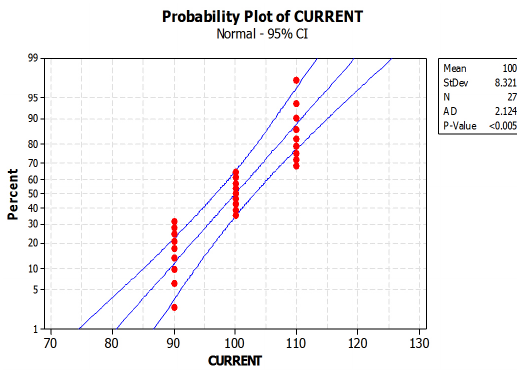
Figure 3. Contour plot of Tensile strength vs Current, Gas flow.